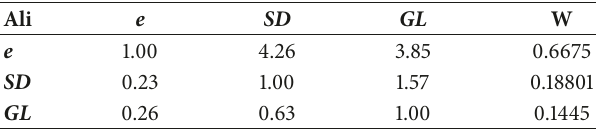
Table 8: Comparison for horizontal curve radius node.